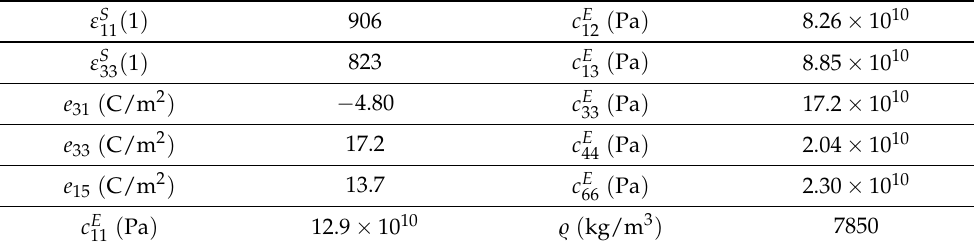
Table 2. Material properties of NCE51